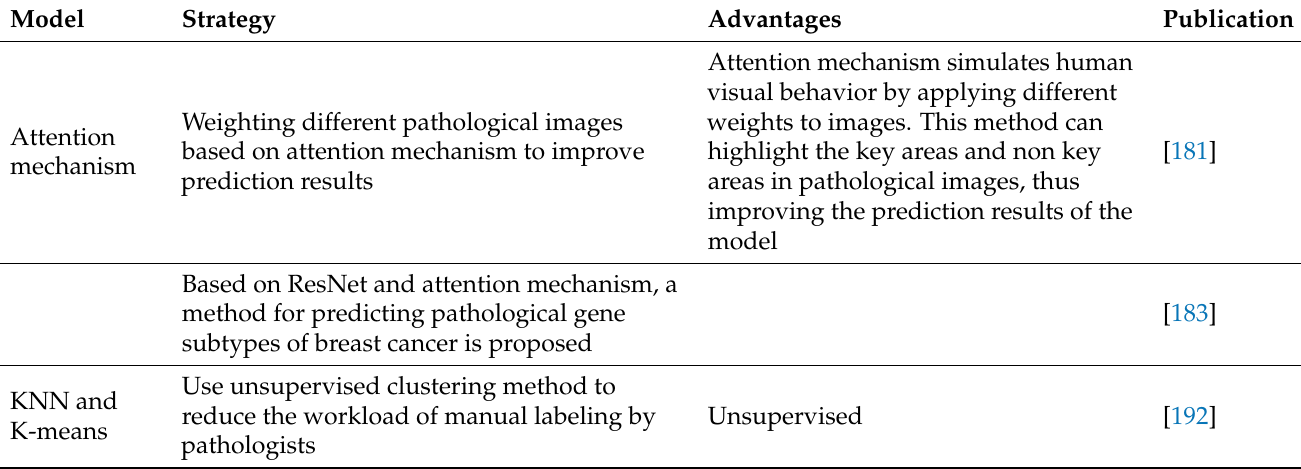
Figure 6. Typical application of deep learning in genetic prediction task. ( a ) MDNNMD model uses multidimensional data to predict the prognosis of breast cancer [186]. ( b ) Estrogen receptor status (ERS) was predicted from the whole-slide image of H&E staining [183]. ( c ) A multi-omics signature to predict the prognosis of invasive ductal carcinoma of the breast [188]. Table 5. Summary of the application of deep learning algorithms in breast cancer histopathology for genetic